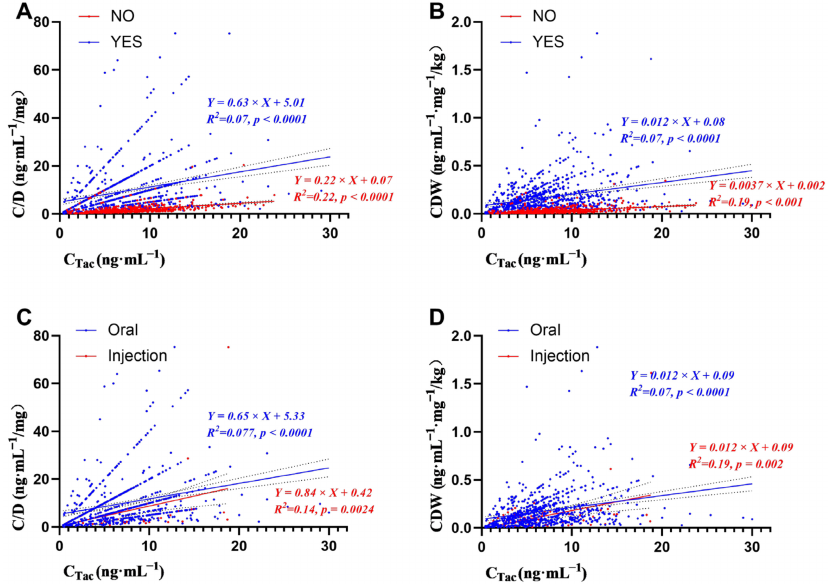
Figure 3. Stratified linear regression of voriconazole use ( A , B ) and its dosage form ( C , D ) on C/D ( A , C ) or CDW ( B , D ). Blue line and dots represent the regression line and values during voriconazole co-therapy; while red line and dots represent the regression line and values without voriconazole